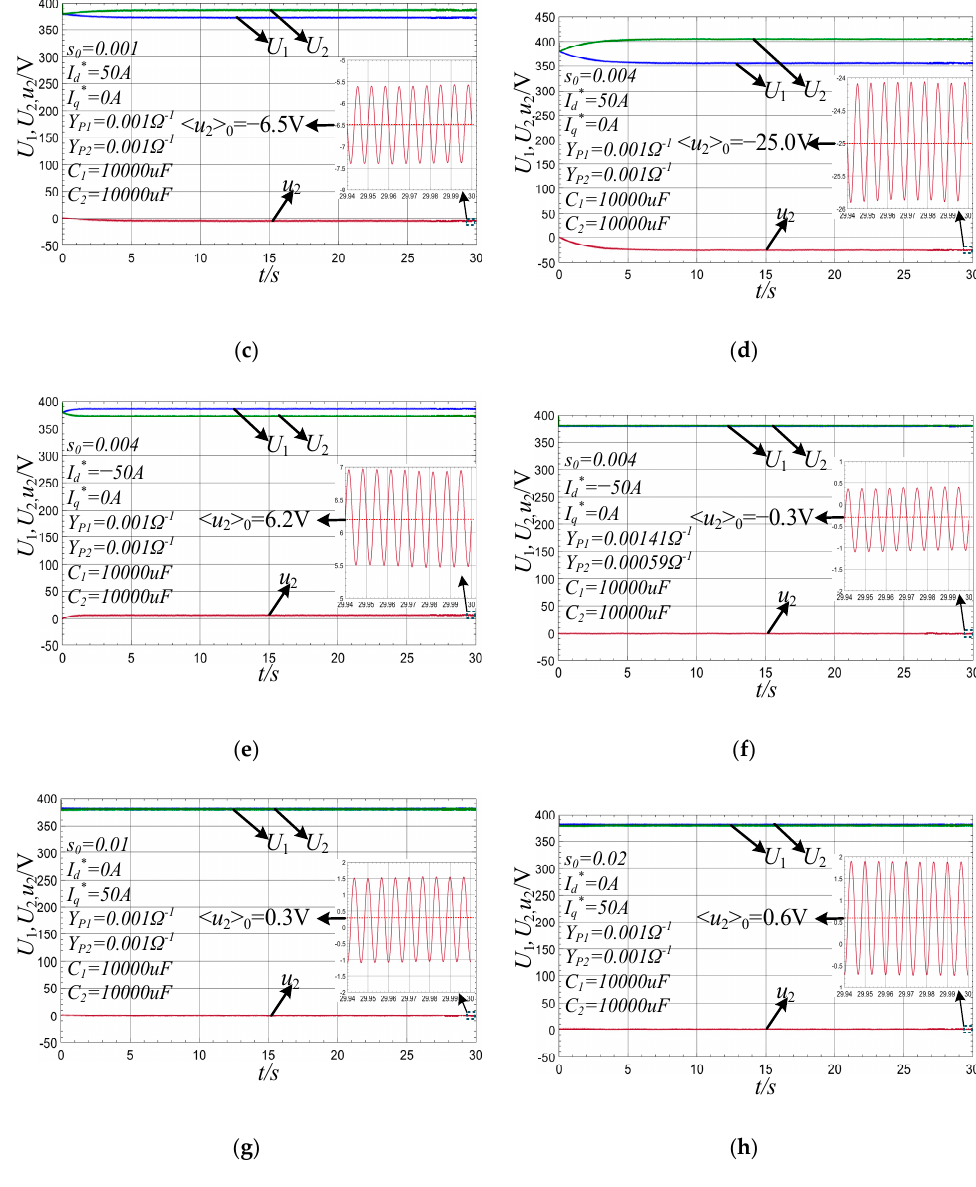
Figure 8. ( a – h ) Waveforms of u 2 when s 0 ≠ 0. Table 5. Values of < u 2 >0 when s 0 ≠ 0.